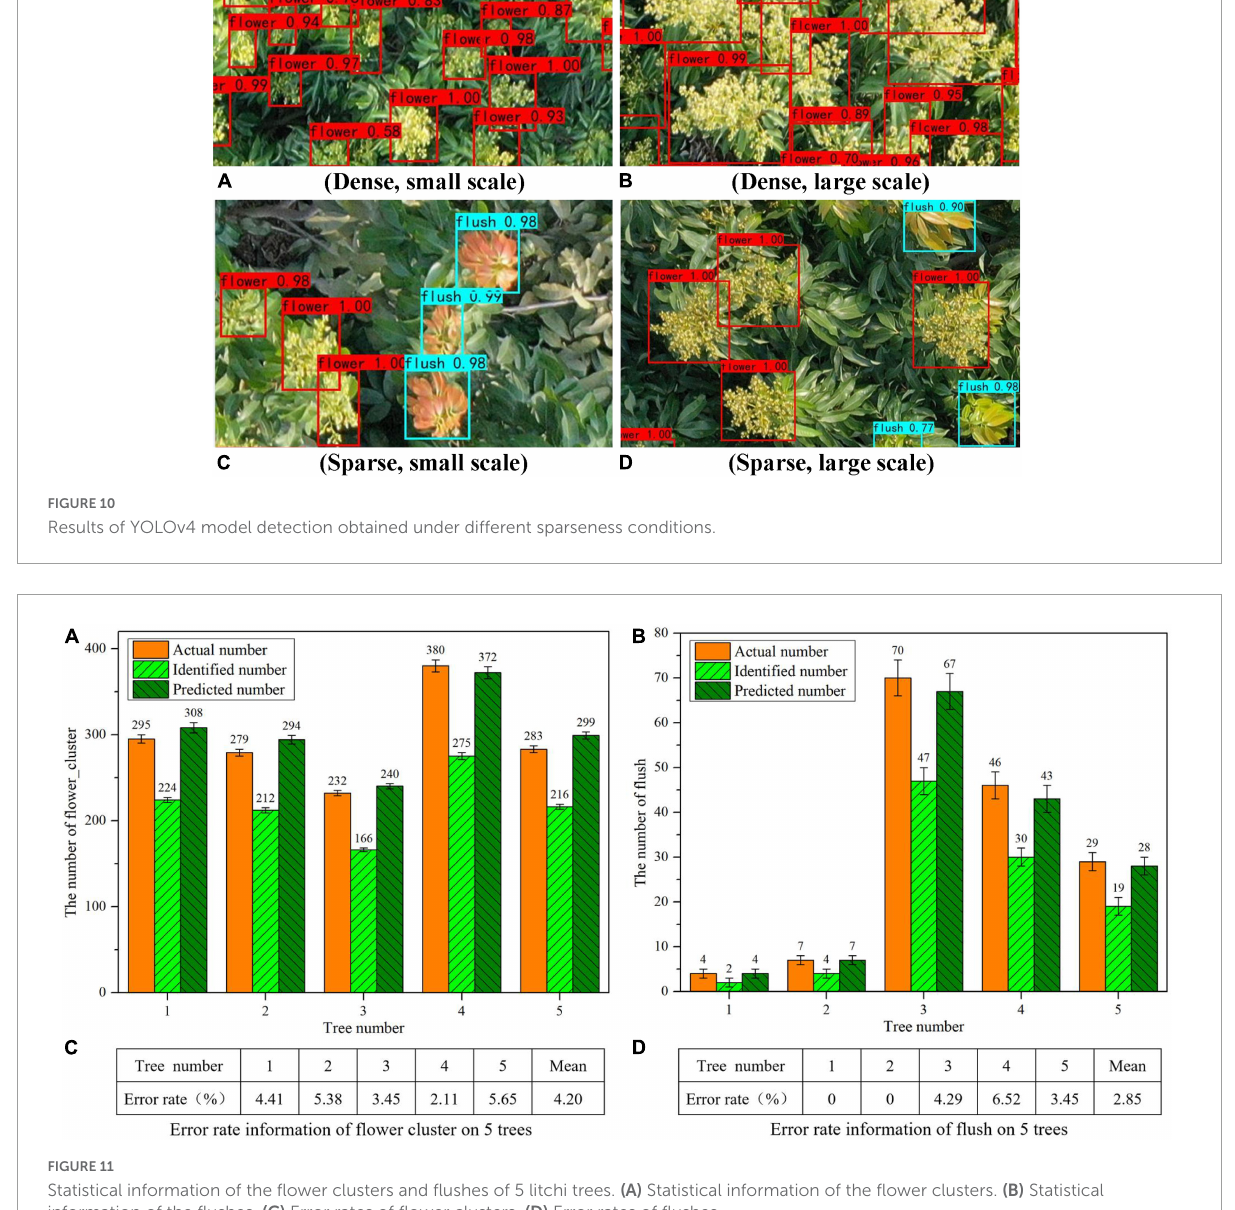
the five trees is 4.20%. According to the data in Figure 11D